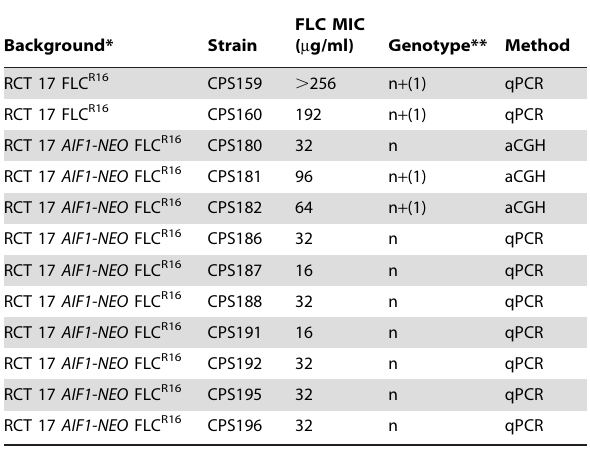
Table 3. Summary of ploidy of FLC R clones.